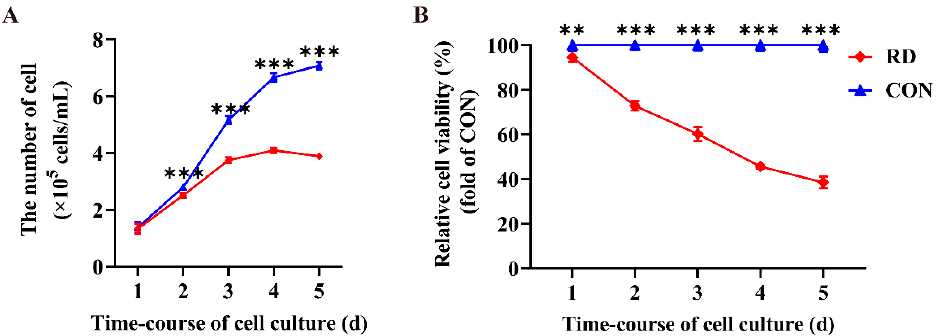
Figure 1. Riboflavin deficiency (RD) decreases cell numbers and relative cell viability. ( A ) Cell numbers in the RD and control (CON) groups vary over time. ( B ) Relative cell viability in the RD and CON groups vary over time. Values are expressed as means ± SD. ** indicates that the differences are significant at p < 0.01; *** indicates that the differences are significant at p < 0.001. Each treatment was performed in six replicates ( n = 6).